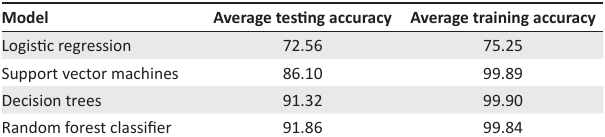
TABLE 4: Model performance. Model